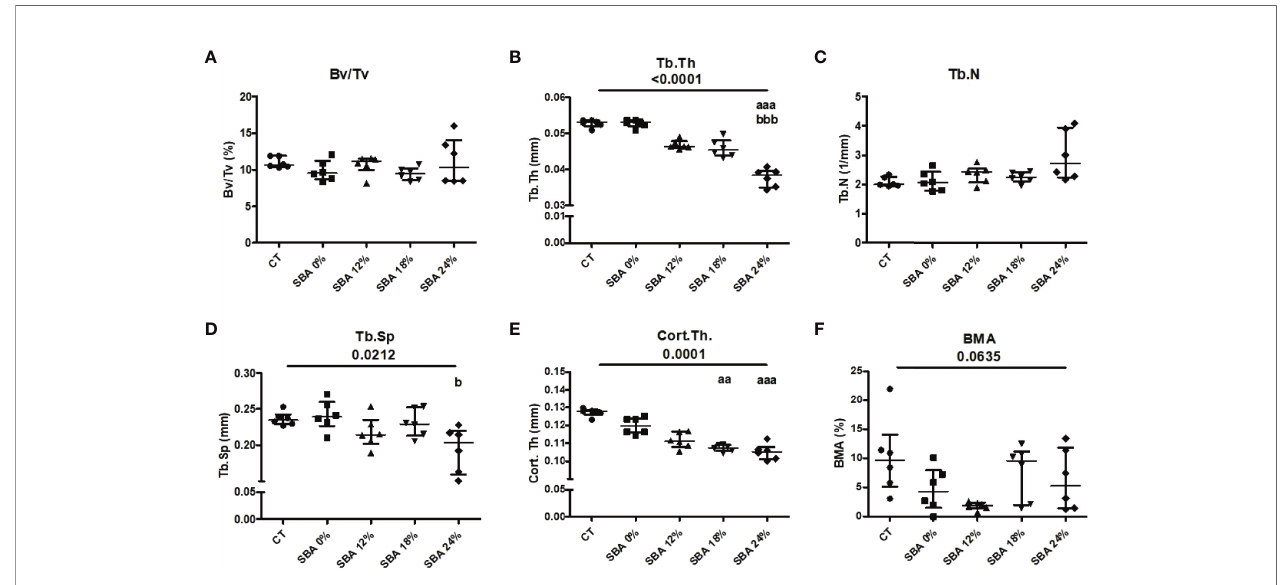
FIGURE 2 | The results of micro-CT analysis of tibia, showing different bone parameters after exposure to 10 weeks of SBA protocols at different levels of severity. (A) Bone volume fraction (BV/TV) was expressed as a percentage on mineralized tissue in each condition after 10 weeks; (B – E) Trabecular thickness (Tb.Th), trabecular number (Tb.N) and trabecular spacing (Tb.Sp), and cortical thickness (Cort.Th), respectively, were evaluated for each animal and each condition after 10 weeks of SBA protocol (expressed in millimetres); (F) Bone marrow adiposity (BMA) was calculated as a percentage of BMAT volume in marrow volume. Data represent median and interquartile range; n = 6. Statistical analysis was performed using Kruskal-Wallis One-Way ANOVA test and Dunn ’ s test; a - p < 0.05, aa - p < 0.005 and aaa - p < 0.0005 when compared to the CT group (b – when compared to the SBA 0% group).